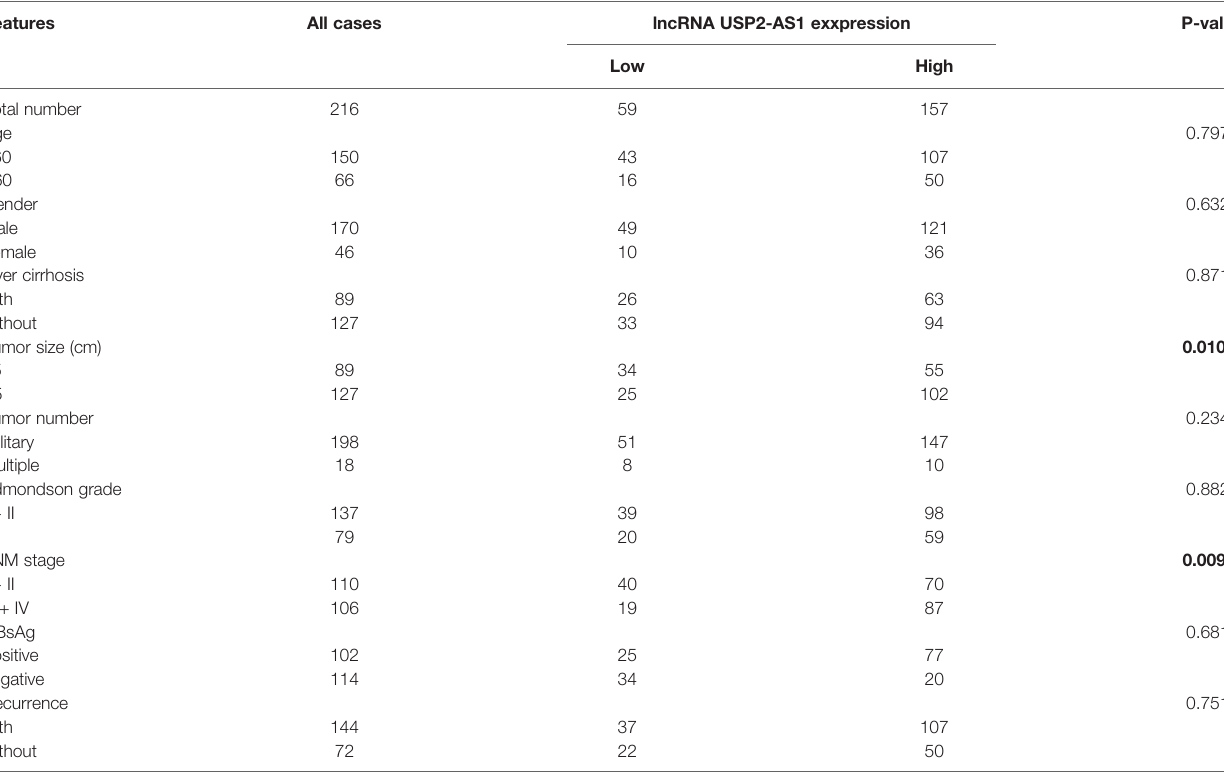
TABLE 1 | The clinic pathological factors of HCC